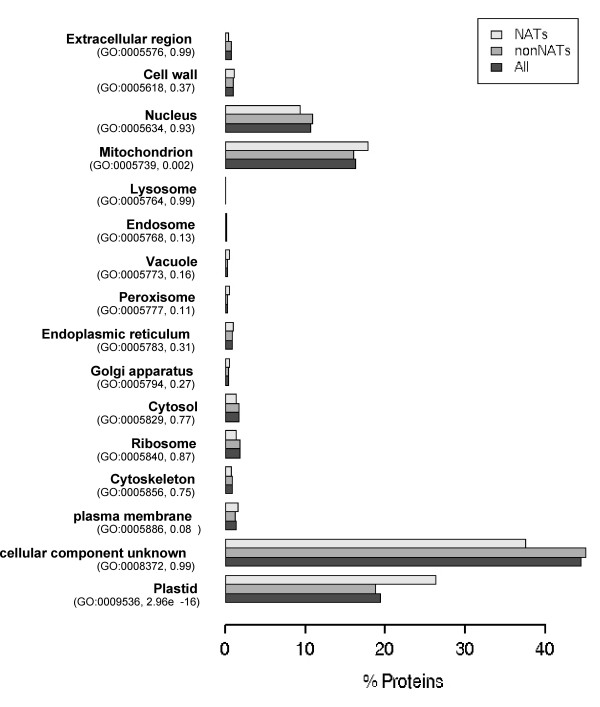
Cellular component GO analysis. The bar plot shows the relative distribution of cellular component GO slim categories among cis-NAT genes, non-NAT genes and all genes in the Arabidopsis genome. The p-values from the hypergeometric distribution test for the NAT genes are in parentheses after the corresponding GO identifiers.